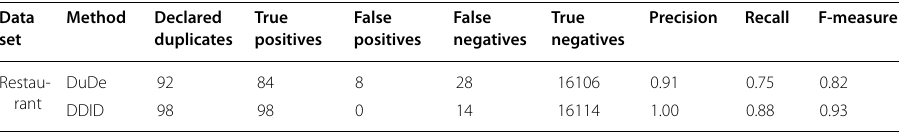
Table 3 Implementation result on the complete restaurant data set Data Method Declared True False False True Precision Recall F-measure set duplicates positives positives negatives negatives Restau- rant